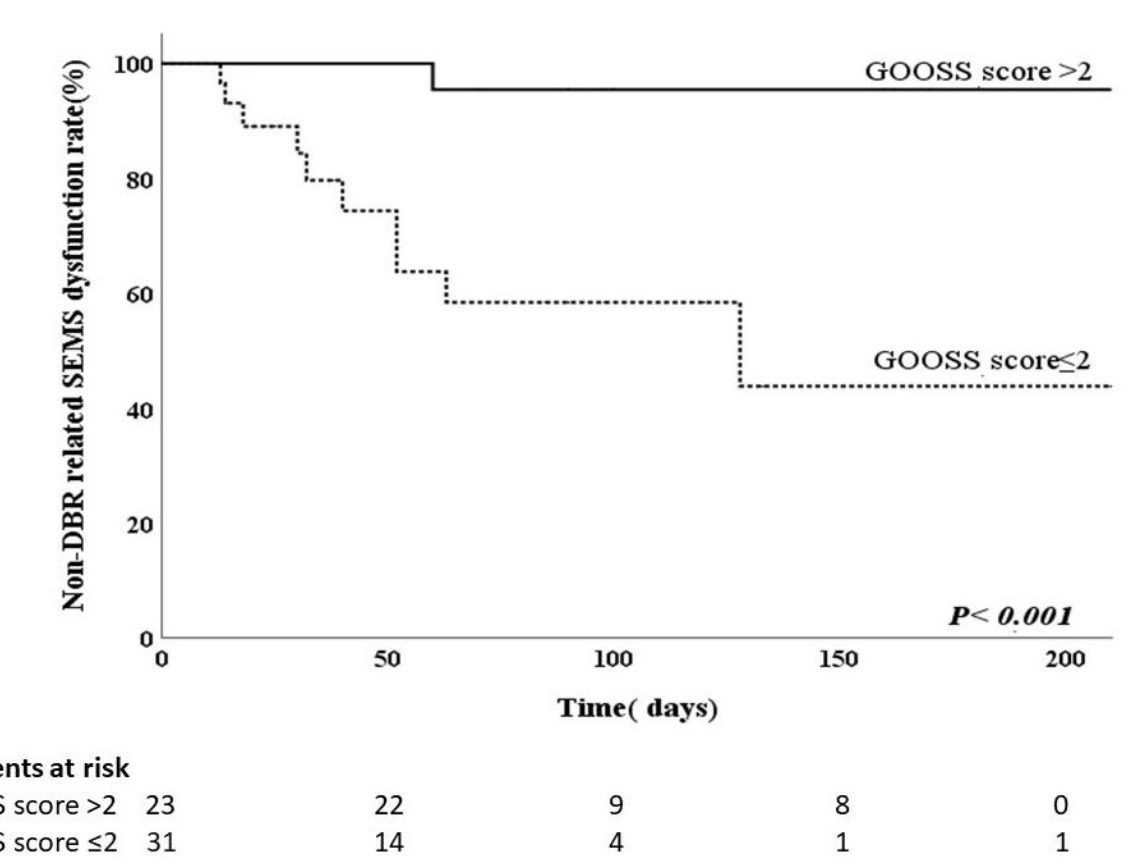
Figure 2. Kaplan–Meier curve showing time to duodenobiliary reflux (DBR)-related covered biliary self-expandable metal stents (SEMS) dysfunction according to gastric outlet obstruction scoring system (GOOSS) after treatment for duodenal obstruction.